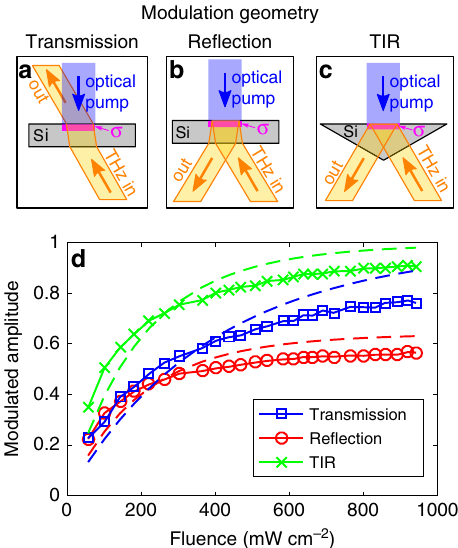
Fig. 1 Modulation depth versus excitation power. a – c The investigated modulation geometries; transmission, re fl ection and total internal re fl ection (TIR) respectively. A CW optical pump (450 nm) photo-excites a conductive layer (indicated by σ ) in silicon. A THz beam is launched at the conductive layer and a detector collects the radiation in the direction indicated by “ out ” in each geometry. The incident angles of the THz beam onto the conductive layer are 8.5°, 8.5° and 30°, respectively. Note that the same silicon wafer used in a and b was placed onto top of the silicon prism in c for truthful comparison. d THz modulation depth as a function of pump fl uence for the different geometries in a – c with the dashed lines being